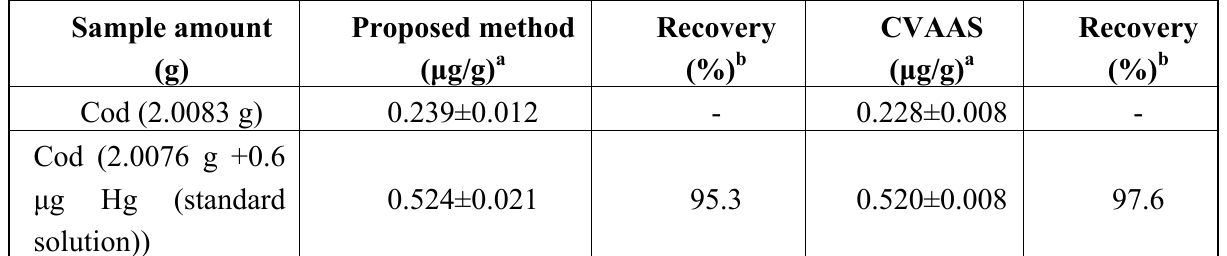
Table 1. Results of mercury determination for a cod sample analysis by the proposed method and